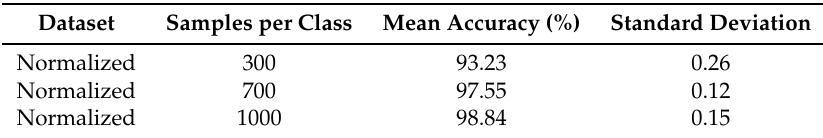
Table 6. Deep Learning experiments with the normalized